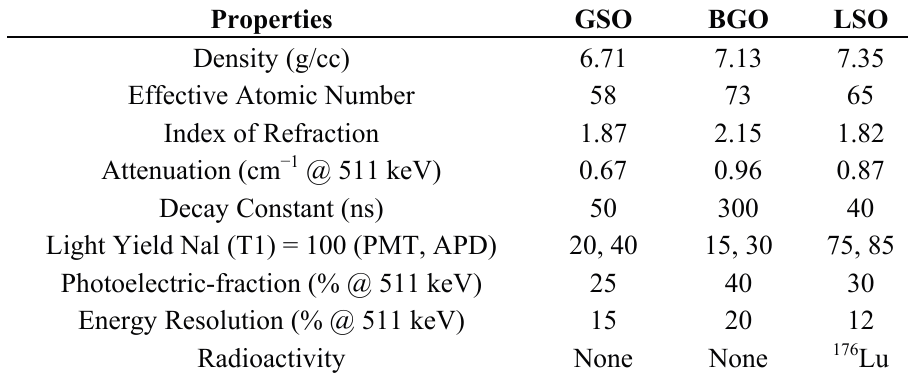
Table 1. Common scintillators use in PET imaging, compiled from various